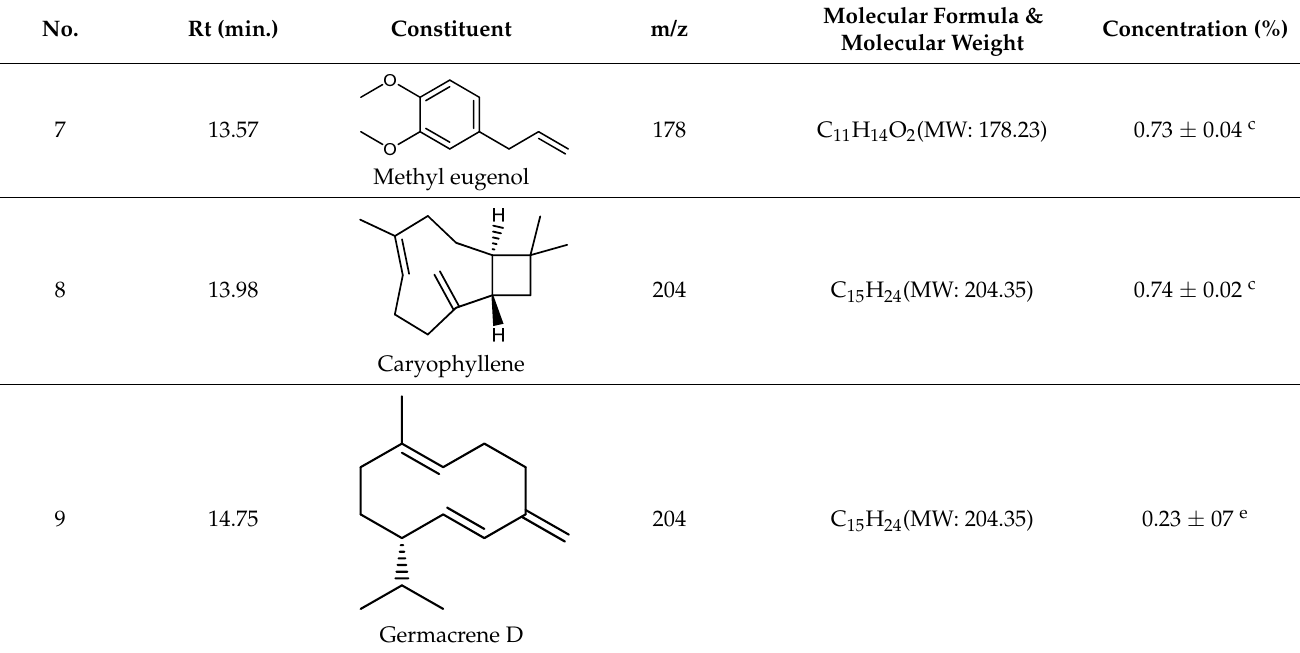
Table 2. Total phenolic and flavonoid contents of methanolic and ethanolic extracts of A. foeniculum AdB; means ± SD.